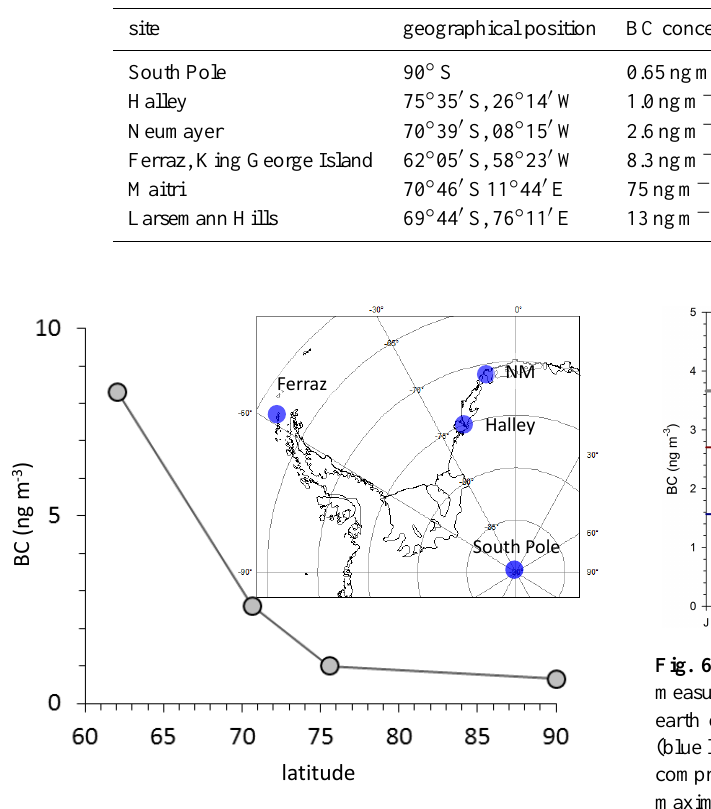
Fig. 5. Spatial BC concentration gradient in Antarctica. Only sites from which annual mean values were available are shown; refer- ences can be found in Table 1.